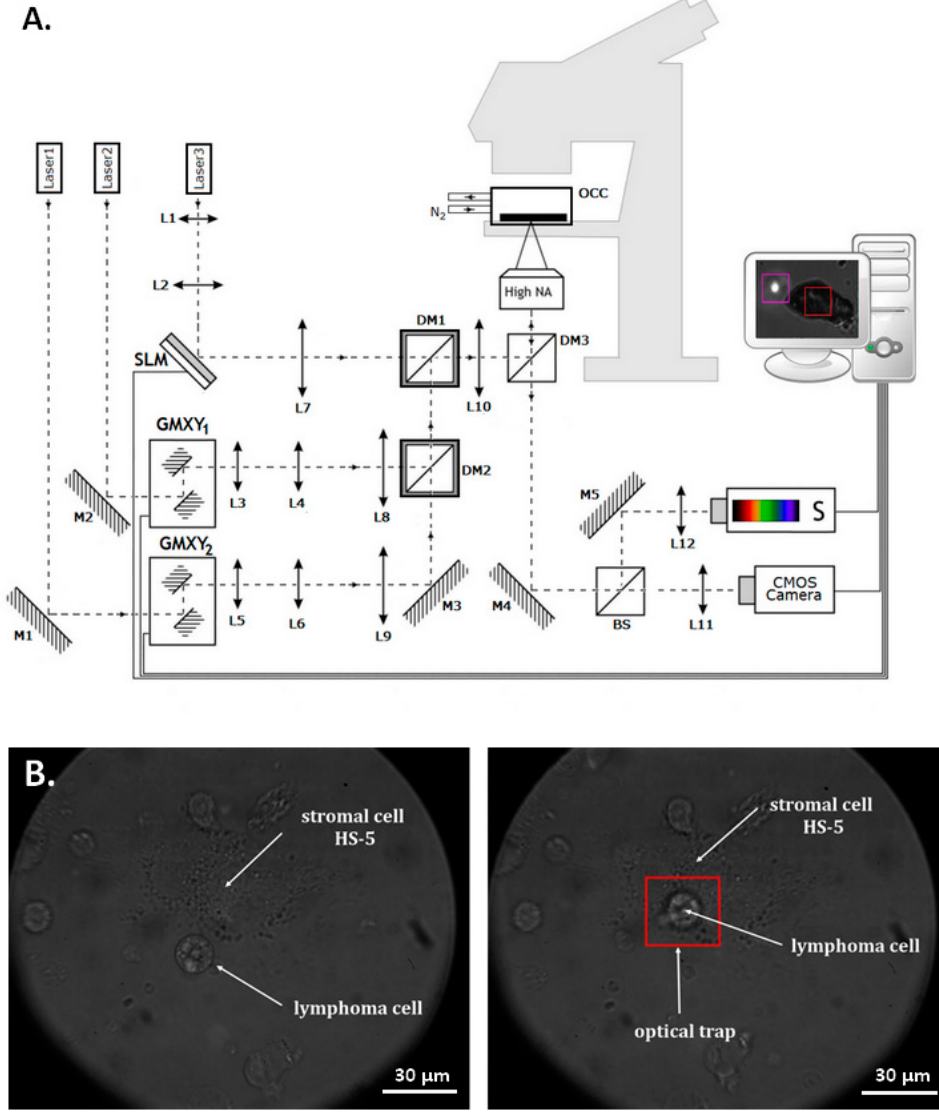
Figure 11. Multifunctional optical tweezers. L1, . . . , L12-lenses, M1, . . . , M5-mirrors, DM1, . . . , DM3-dichroic mirrors, SLM-spatial light modulator, GMXY1,2-Galvano-mirror XY scanning system, BS-beamsplitter, S -spectrophotometer, high NA-high numerical aperture objective, OCC-oxygen controlling chamber ( A ). Lymphoma-stromal cell interaction study in optical tweezers ( B ). Toledo cell held in optical trap ( left ) following by assembling to the marrow stromal cell ( right ). The red frame indicates the area of operating range of the optical trap, while the focused laser beam is located in the center of trapped specimen.